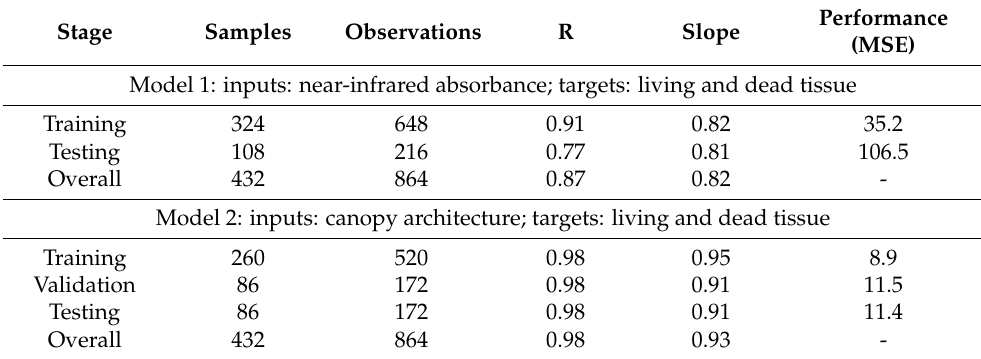
Table 3. Statistical data for each stage of the artificial neural network regression Models 1 and 2.